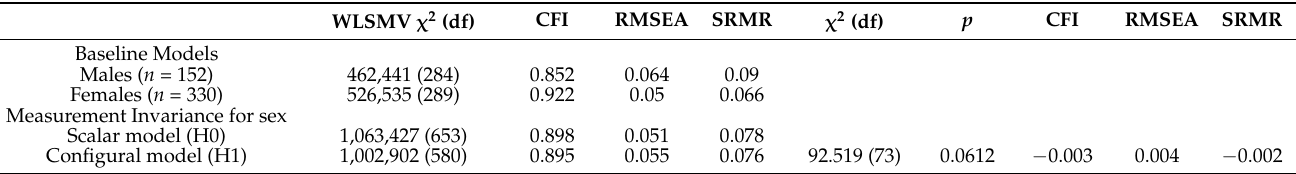
Table 4. Measurement of invariance in the CFA